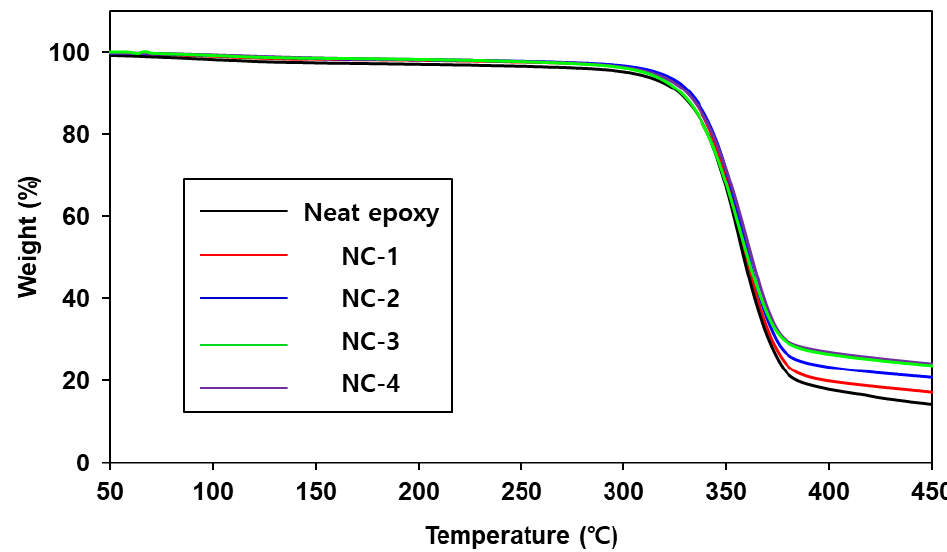
Figure 8. TGA thermograms of neat epoxy and nanocomposites. Table 2. Glass transition temperature of neat epoxy and nanocomposites. Neat Epoxy